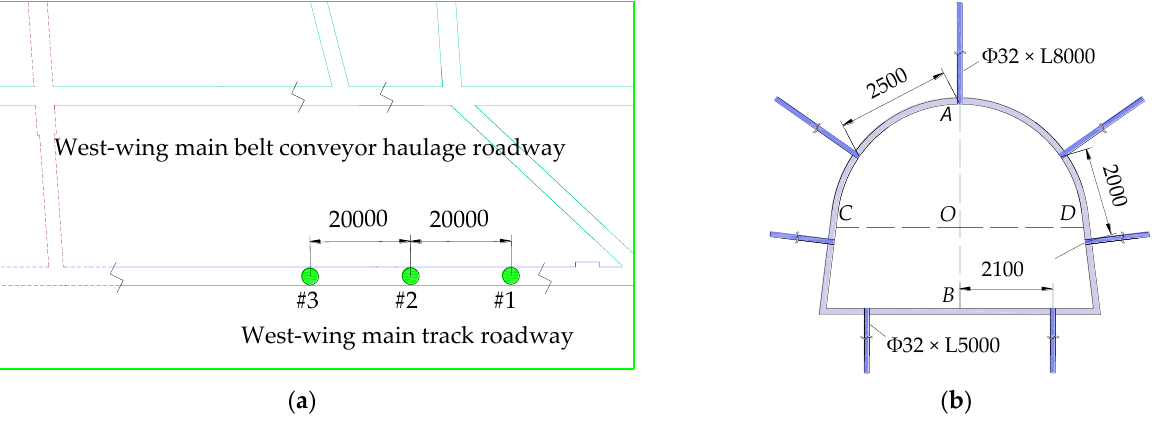
Figure 9. Observation scheme of deep failure of the surrounding rock (Unit: mm): ( a ) station arrangement positions; ( b ) peep borehole parameters.